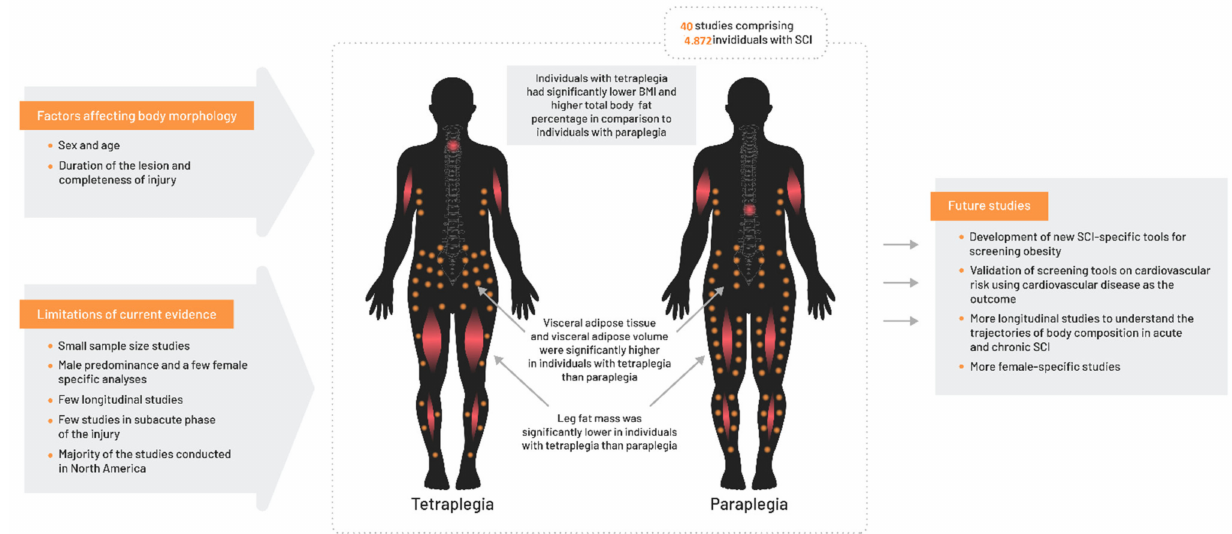
Figure 2. Summary of important